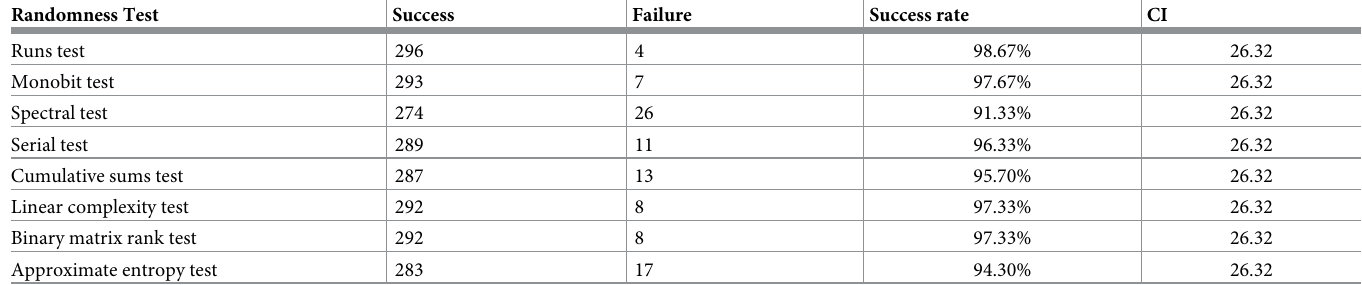
Table 5. Plaintext avalanche